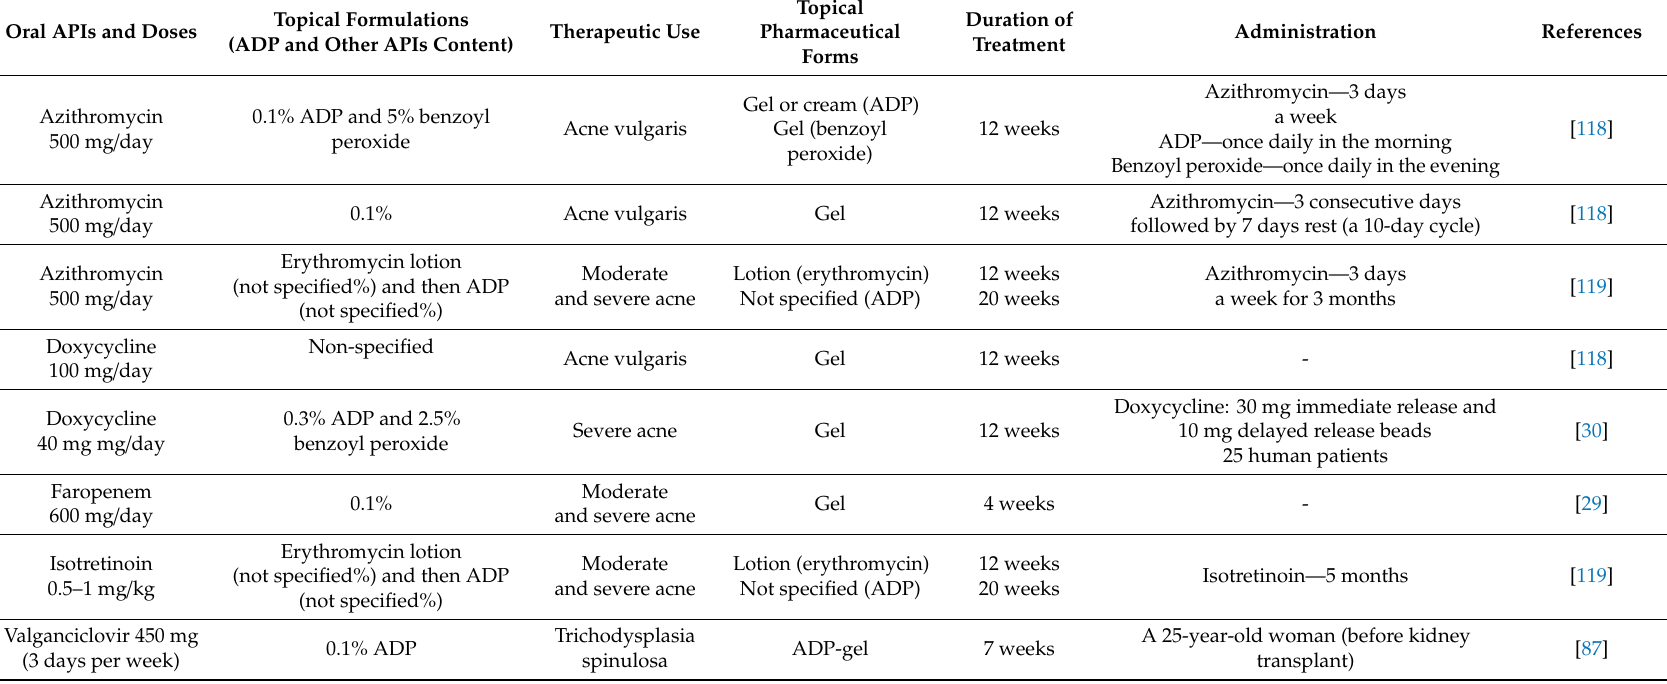
Table 6. Treatment regimens: oral drugs and topical pharmaceutical forms of adapalene